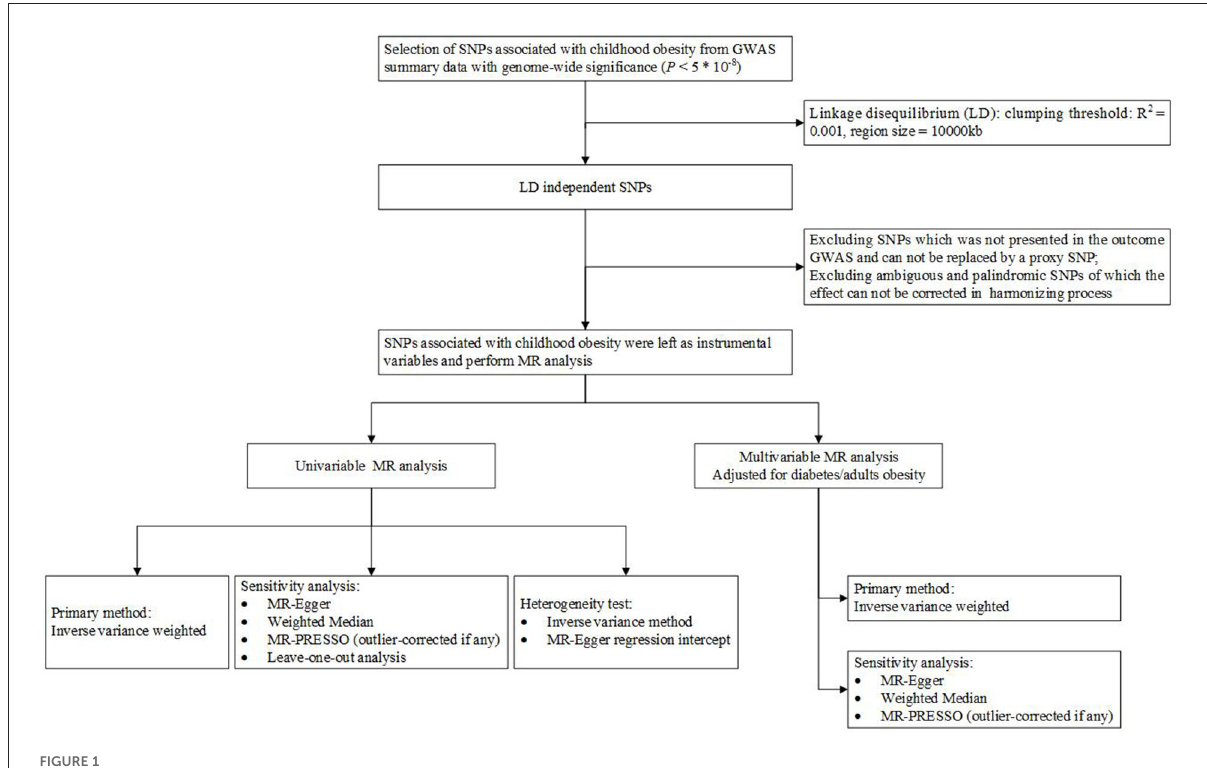
FIGURE1 Flowchart of this study.